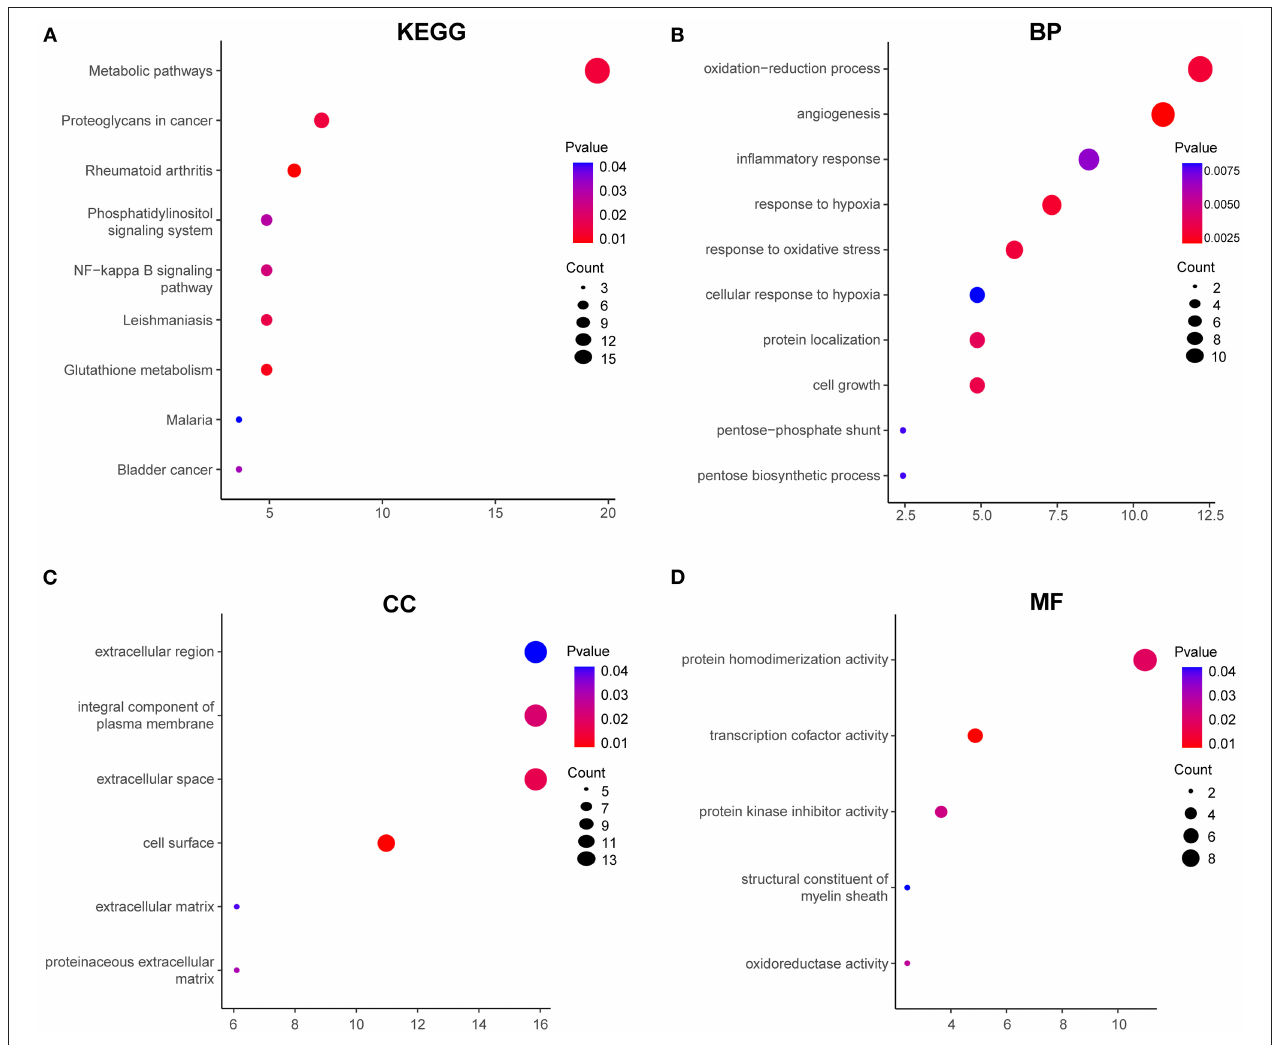
FIGURE 5 | GO functional and KEGG enrichment analyses of 82 DEGs in the coexpression network. (A) Significantly enriched KEGG pathways. GO functional enrichment analysis includes BP (B) , CC (C) , and MF (D) . Red to blue colors indicate low to high levels of p -value. Point size indicates the number of DEGs in the corresponding